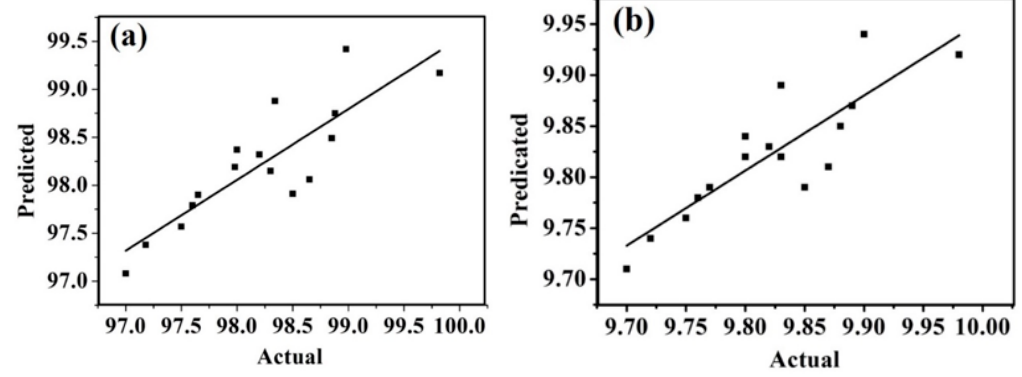
Figure 1. Parity plot of actual and predicted values of ( a ) removal (%) and ( b ) uptake capacity (mg·g − 1